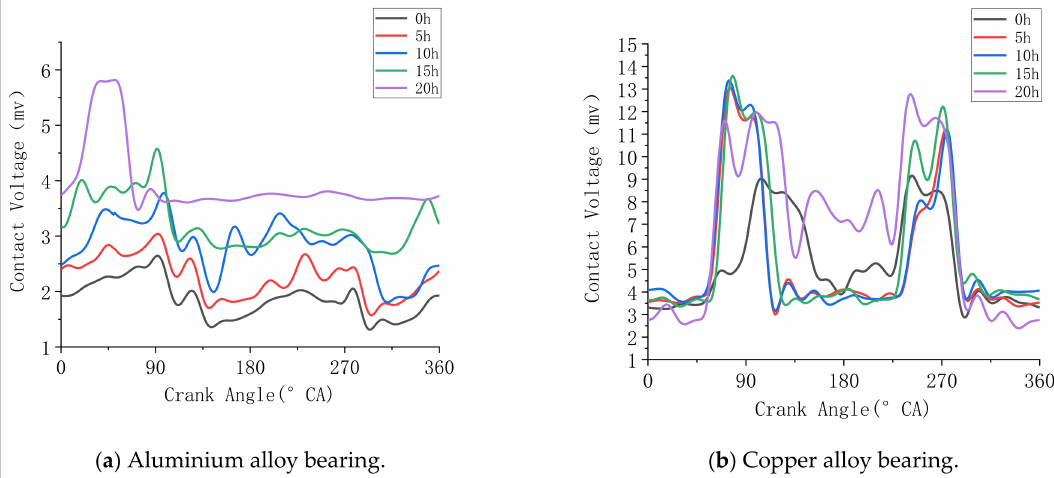
Figure 16. CV signals of the different wear times.